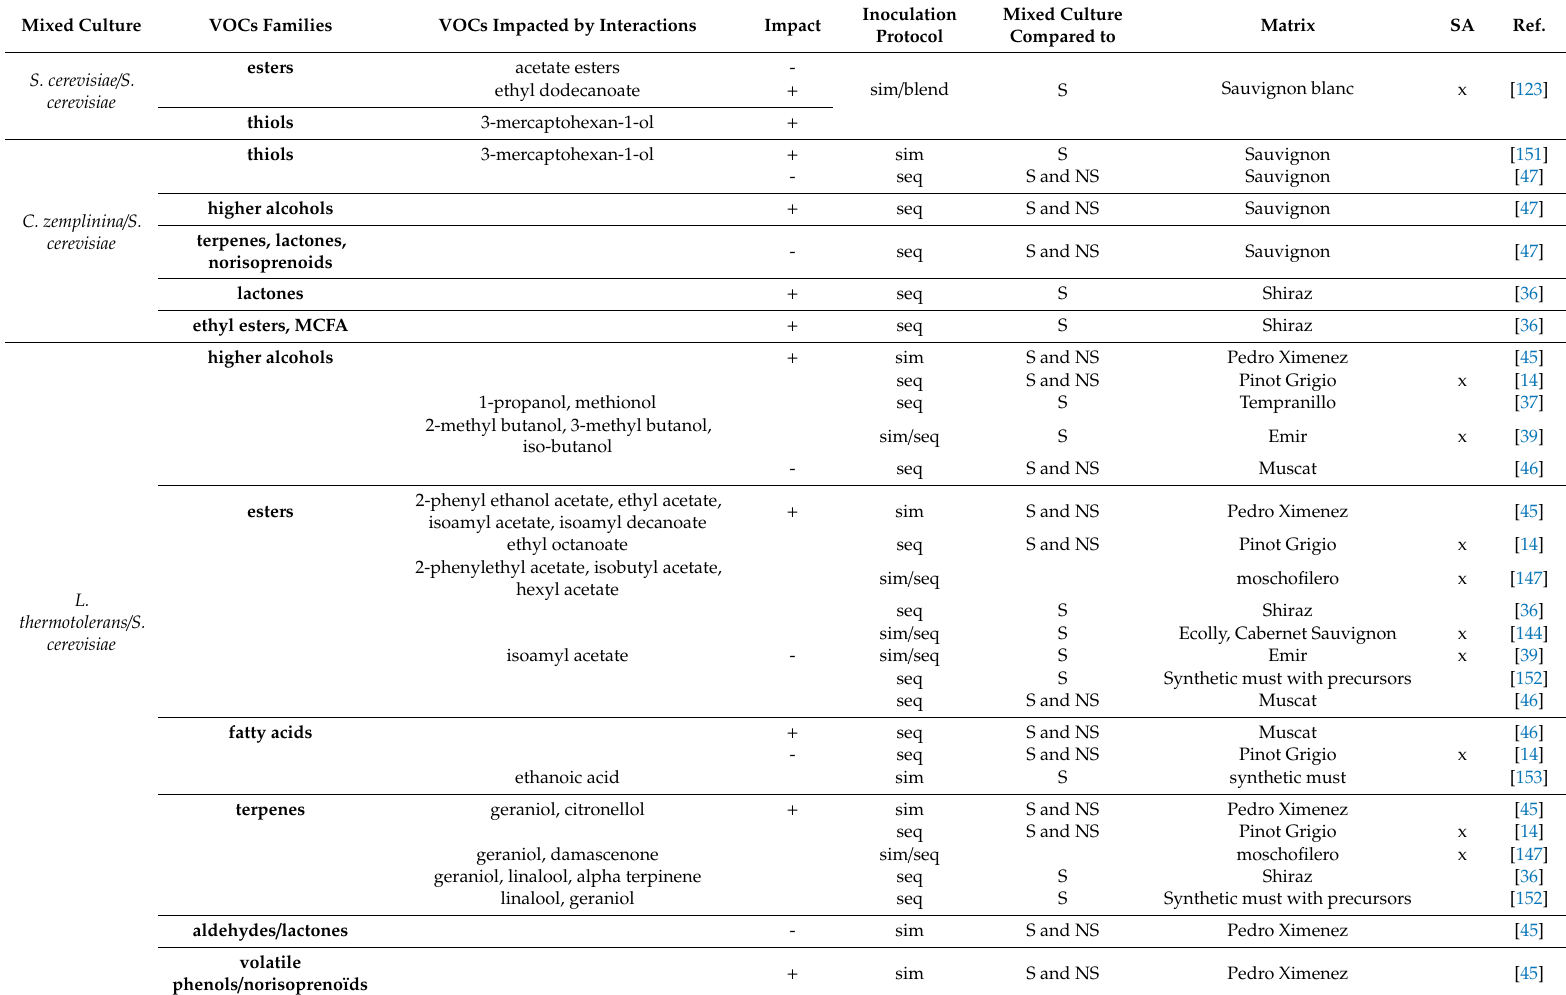
Table 2. Impact on volatile organic compounds of di ff erent mixed